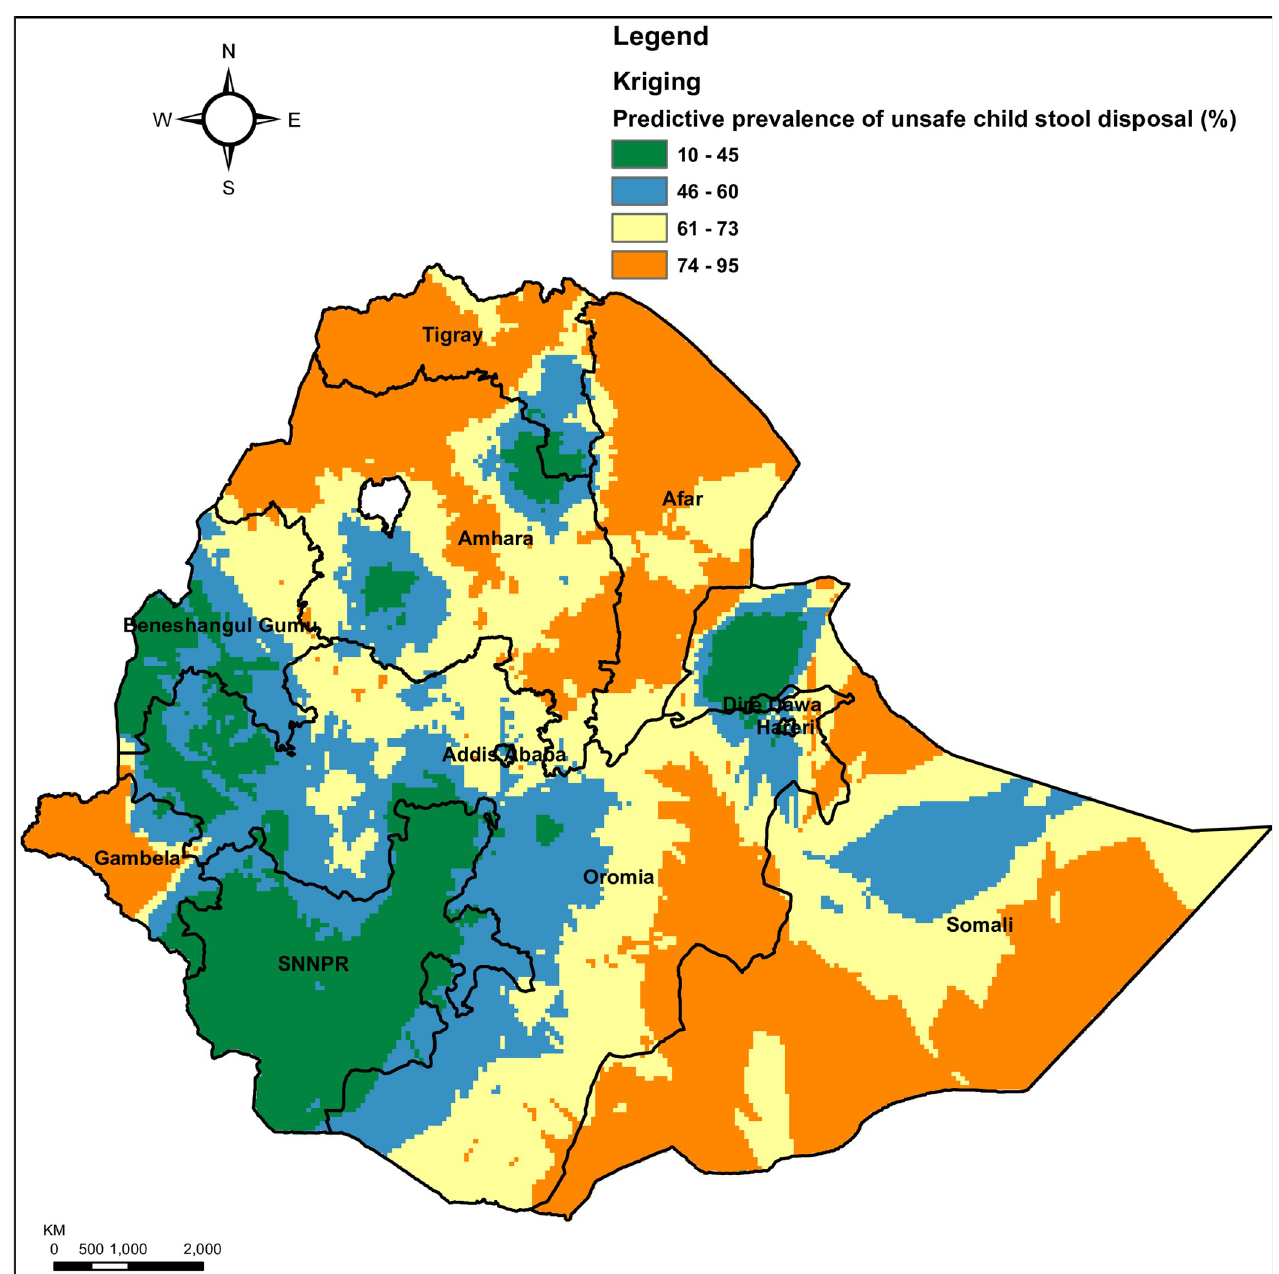
Fig 2. Ordinary kriging interpolation of unsafe child stool disposal in Ethiopia, EDHS 2016. Source: Shapefile of the map was freely available from https:// africaopendata.org/dataset/ethiopia-shapefiles.